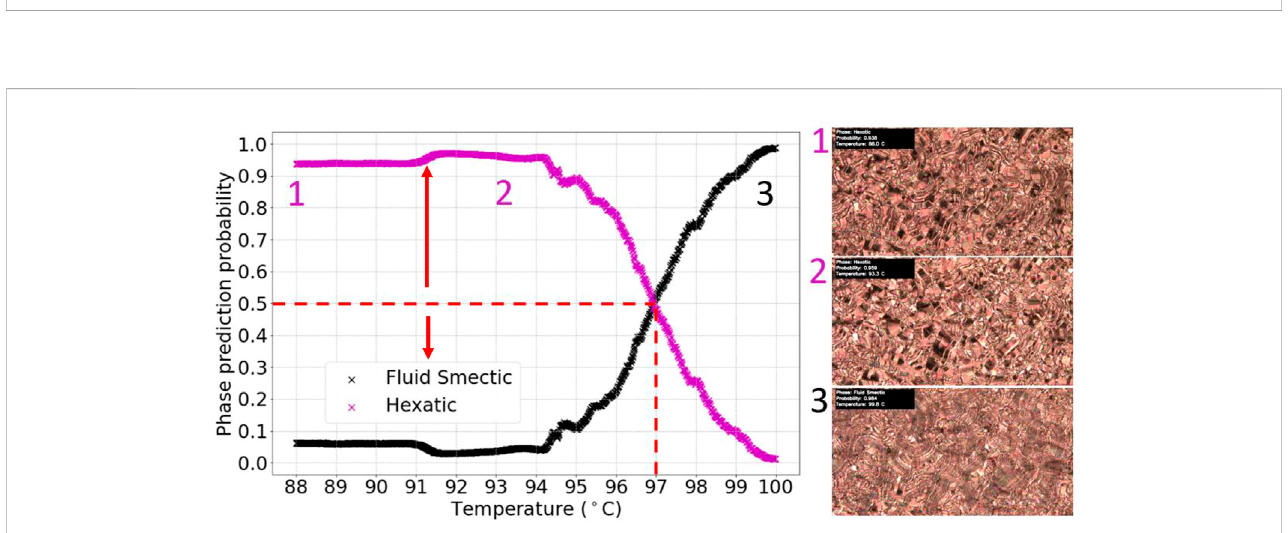
FIGURE 10 Graph of phase prediction probability against temperature for a labelled chiral fl uid smectic- hexatic (SmC*-SmI*) transition test video. The vertical dashed line shows the incorrectly identi fi ed transition temperature, due to changes in the helical superstructure, while the arrow indicates the real transition.